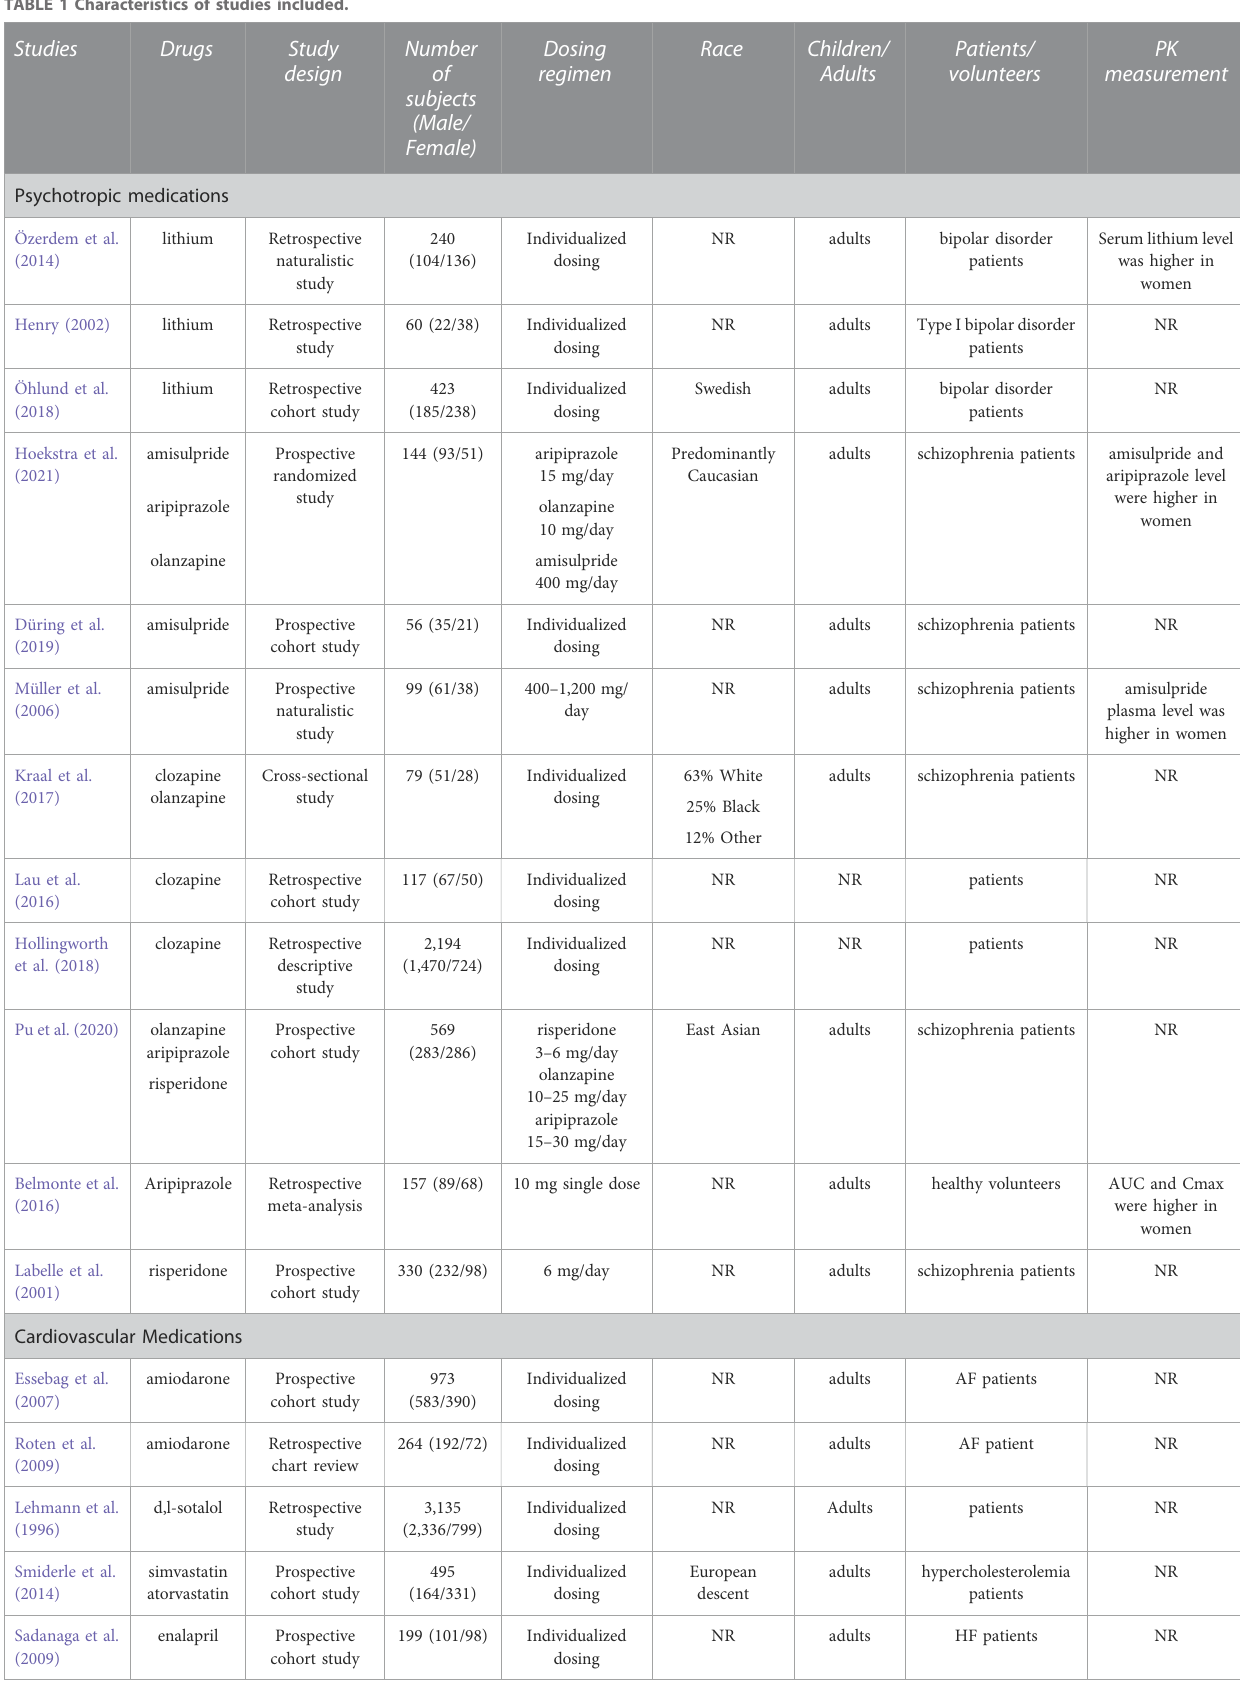
TABLE 1 Characteristics of studies